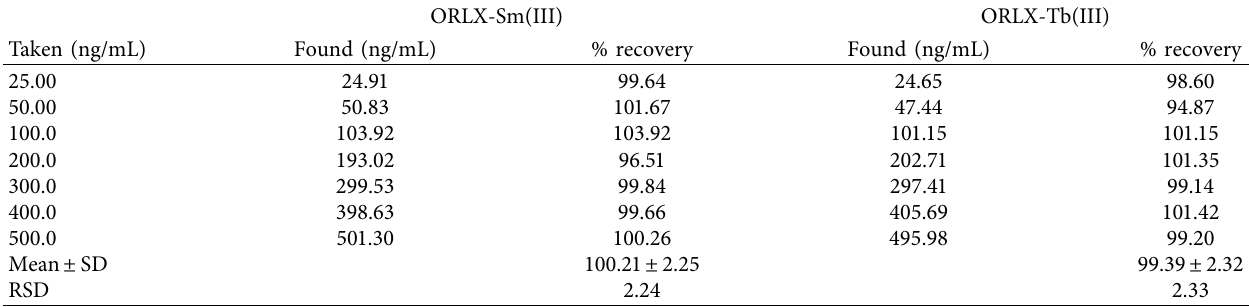
Table 7: Determination of ORLX in the bulk powder using the optimum